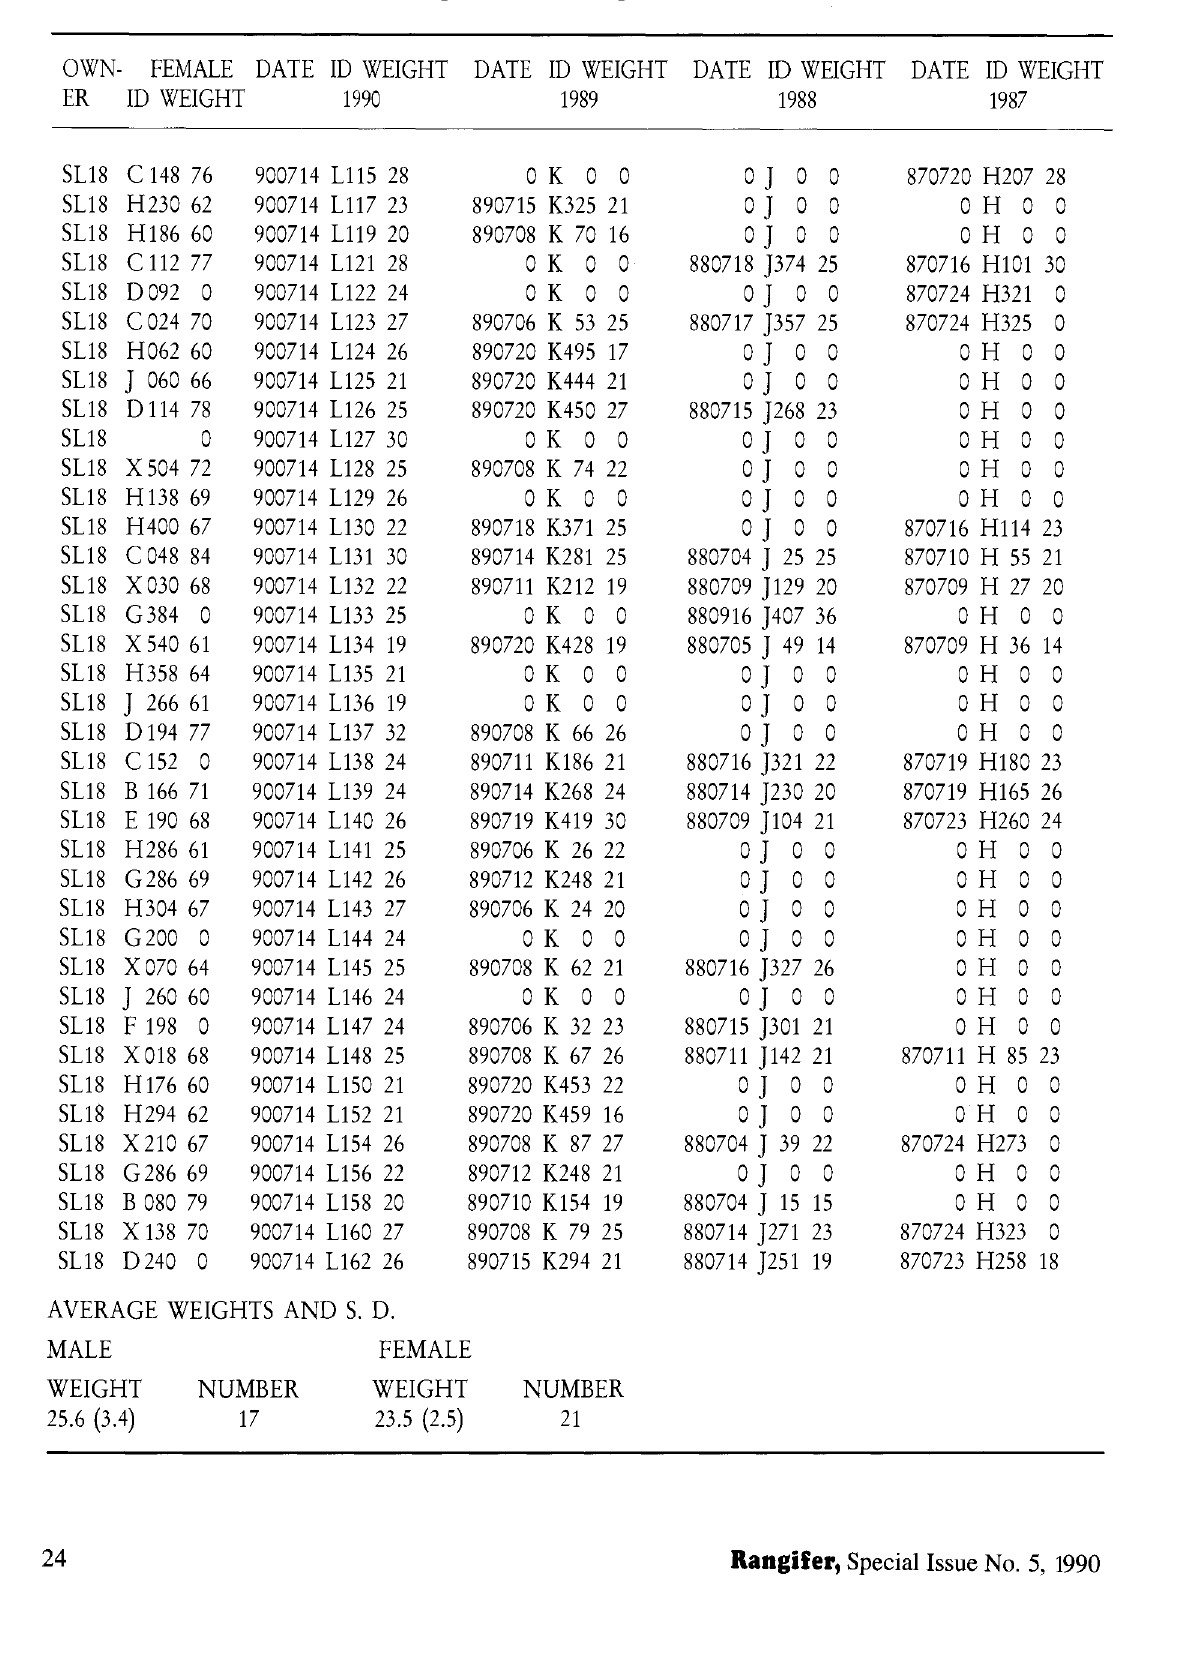
Table 2. Example on daily output during summer